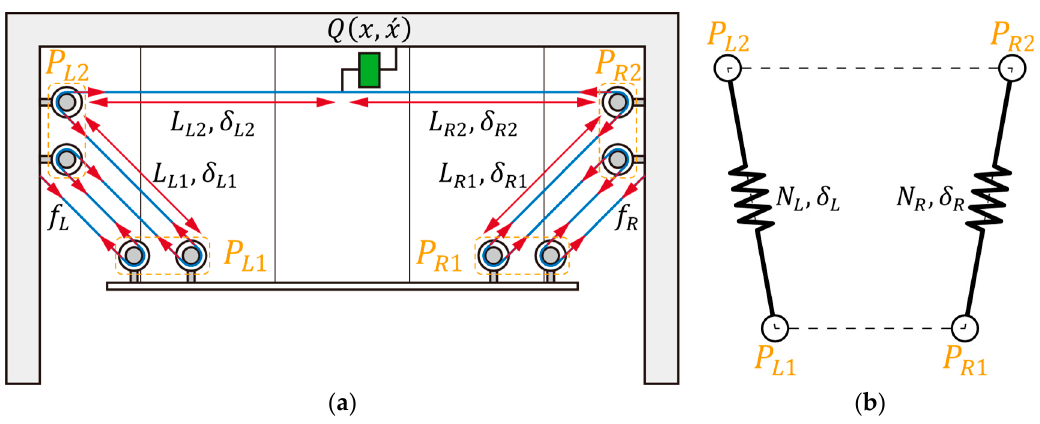
Figure 3. ( a ) Configuration model; ( b ) equivalent truss model.